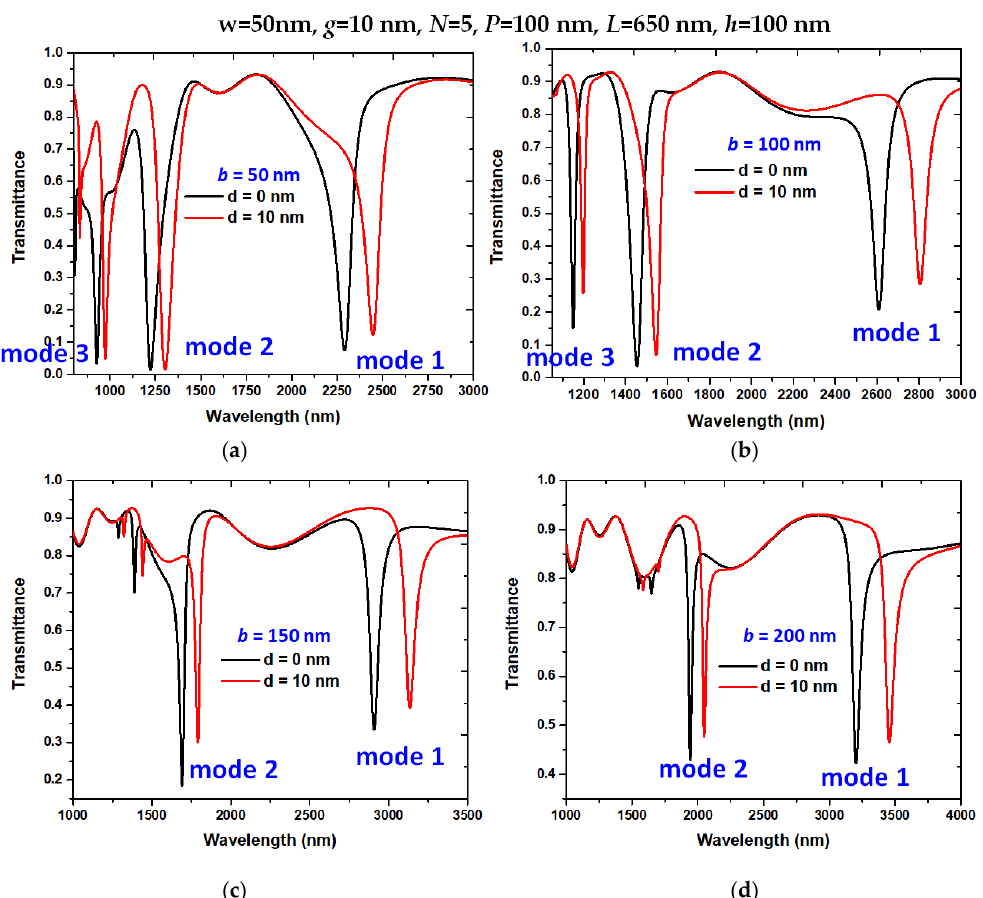
Figure 7. Transmittance spectra of the designed structure with variation of the height of stubs ( b ), ( a ) b = 50 nm, ( b ) b = 100 nm, ( c ) b = 150 nm, and ( d ) b = 200 nm, Figure 8a–d depict the transmittance spectra of the designed structure with a varia- tion of the number of stubs ( N ), when N = 3, 5, 7, and 9, respectively. In these cases, the corresponding length of horizontal slot ( L ) is 350 nm, 650 nm, 950 nm, and 1250 nm, re- spectively. In Equation (7), the structural parameter L is positively proportional to sensi- tivity (S), which means that a more significant stub number ( N ) will receive higher pres- sure sensitivity. As observed in Figure 8a–d, the resonance wavelength and the number of modes increases with increasing N . We summarized ( ∆λ res , S) of the designed structure for N = 3, 5, 7, and 9 in Table 3. Based on Figure 8 and Table 3, ( ∆λ res , S) reveals a significant advance with increasing N , e.g., ∆λ res , and S in mode 1 achieved 364 nm and 592.44 nm/MPa when N = 9. However, a more significant N representing the greater number of stubs could enlarge the resonator’s size and increase Ohmic loss in bus WG and resonator. These values obtained from Table 3 are much higher than those of reported articles. We compare the designed plasmonic pressure sensor with the published designs in Table 4. The designed structure displays the most heightened sensitivity ( ≈ 23.32 times) than com- pared to [50] to the best of our knowledge. In addition, the pressure (in the unit of Pa) applied to the designed sensor can be calculated based on the Equations (5) and (7). For example, when the parameters of ( w , g , N , P , L , h ) = (50 nm, 10 nm, 97, 100 nm, 650 nm, 100 nm), the measurable minimum pressures are about 8.404 Pa, 8.410 Pa, and 8.406 Pa for modes 1, 2 and 3, respectively.